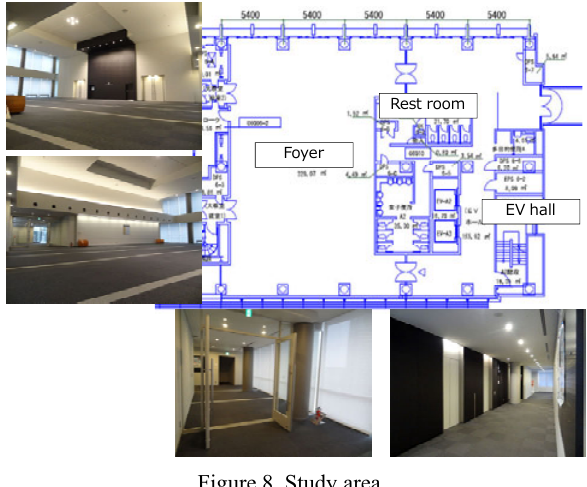
direction and 2 cm in the height